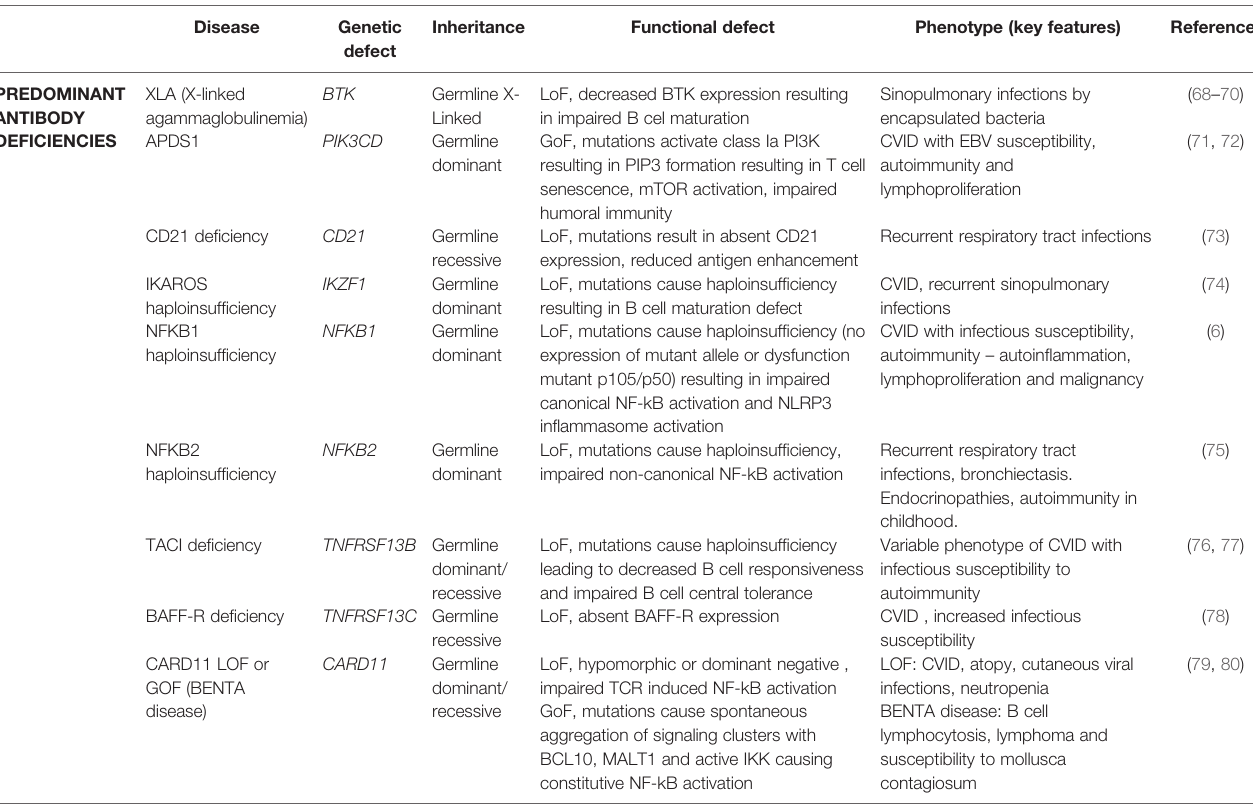
TABLE 3 | Genes associated with adult-onset predominant antibody de fi